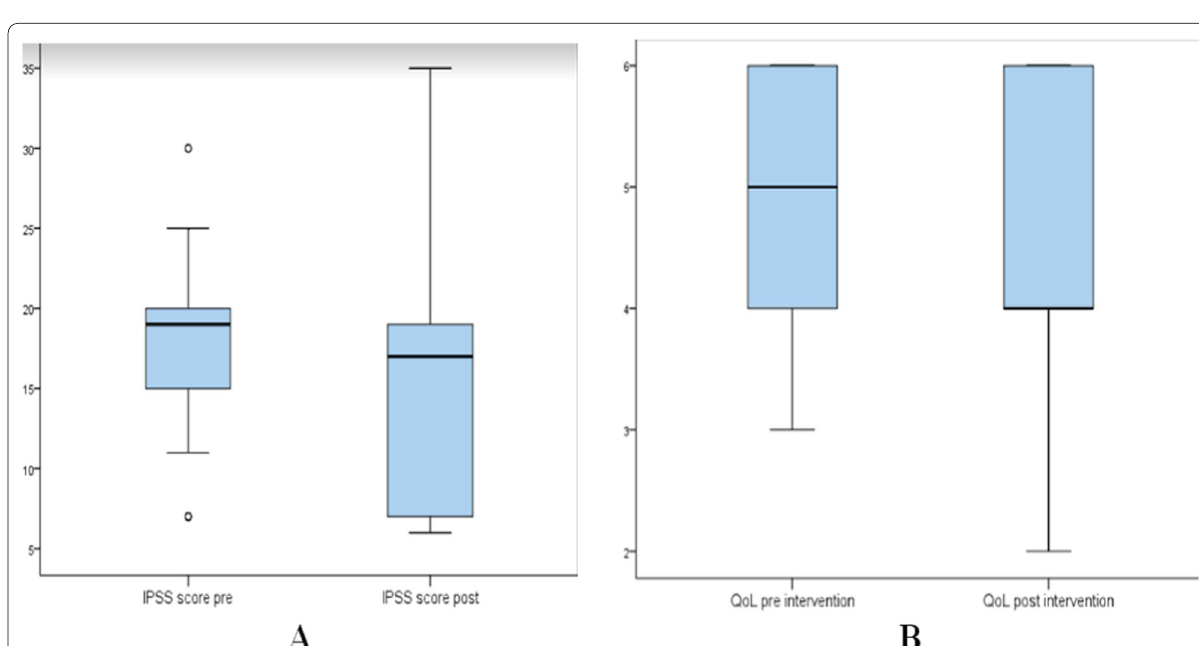
Fig. 10 Box and Whisker charts demonstrating the skewness of the distribution of the pre and post sclerotherapy IPSS and QoL